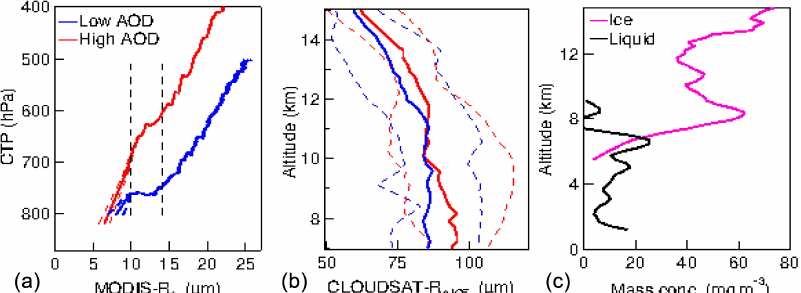
Figure 5. Observed differences in cloud microphysical properties for low and high aerosol loadings cases. (a) MODIS-observed mean profiles of liquid-phase effective radius ( R e ) ; (b) CloudSat-observed mean profiles of ice-phase effective radius ( R e , ICE ) under low (blue) and high (red) aerosol loading conditions. The dotted lines represent 25th and 75th percentiles, respectively. (c) Difference (high AOD–low AOD) in mean profiles of liquid-phase (black) and ice-phase (pink) water content as observed from CloudSat.